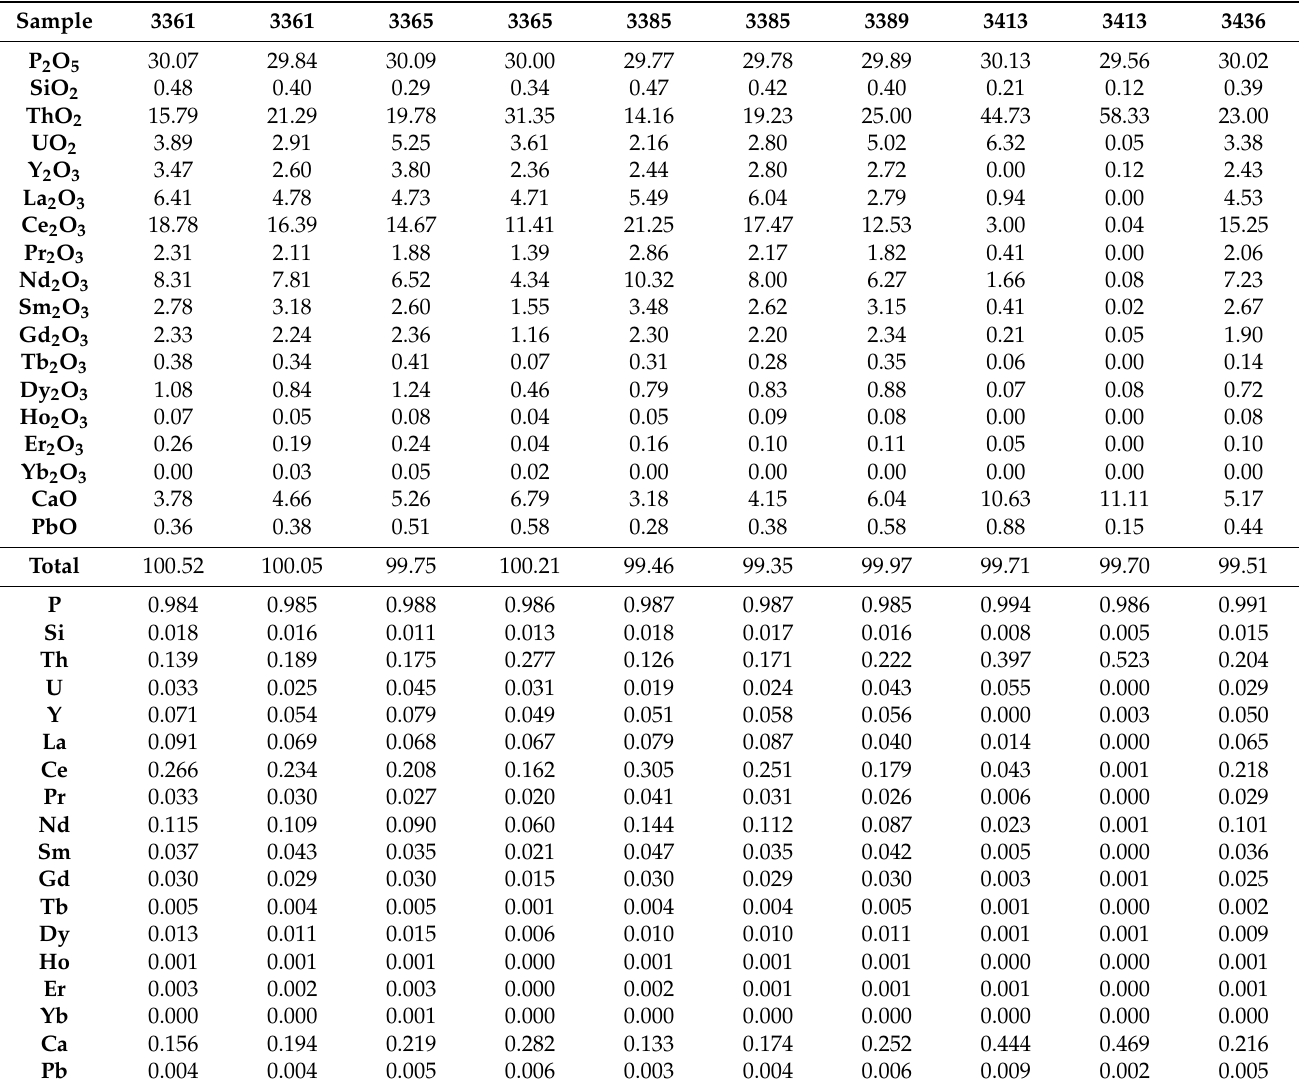
Table 2. Representative results (wt%) of electron microprobe analyses of monazite-(Ce) and monazite–cheralite s.s. from Podles í . Formulae (in atoms per formula unit, apfu ) based on 4 oxygen atoms.